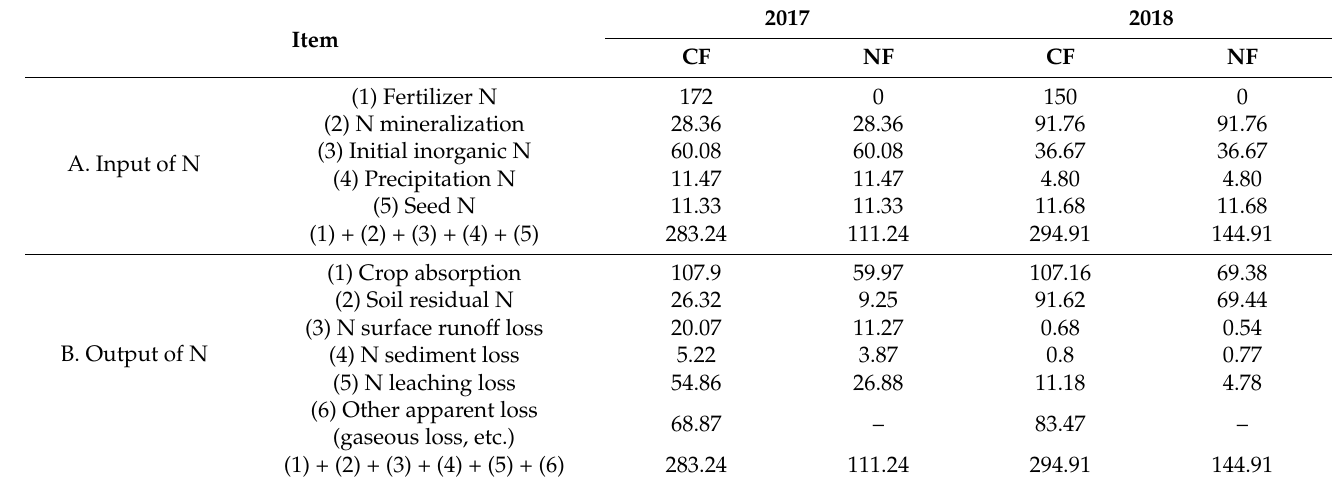
Table 7. N balance in peanut-growing period. Unit: N kg ha − 1 .